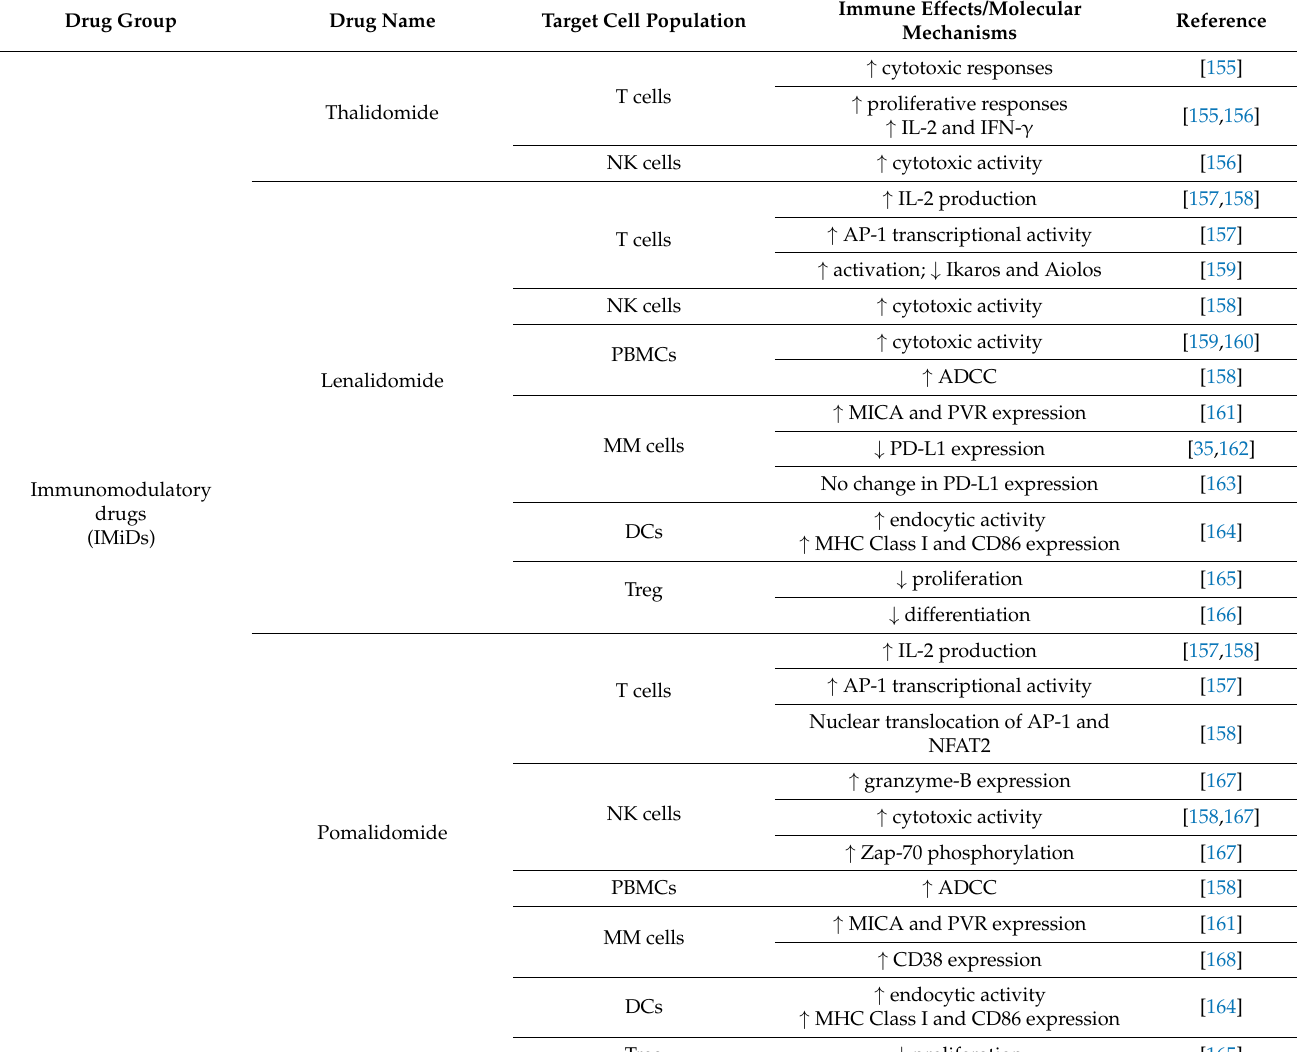
Table 1. Summary of the main immunomodulating effects of immunomodulatory drugs (IMiDs), proteasome inhibitors, histone deacetylase inhibitors, cyclophosphamide, arginase inhibitors and IDO inhibitors. Drug